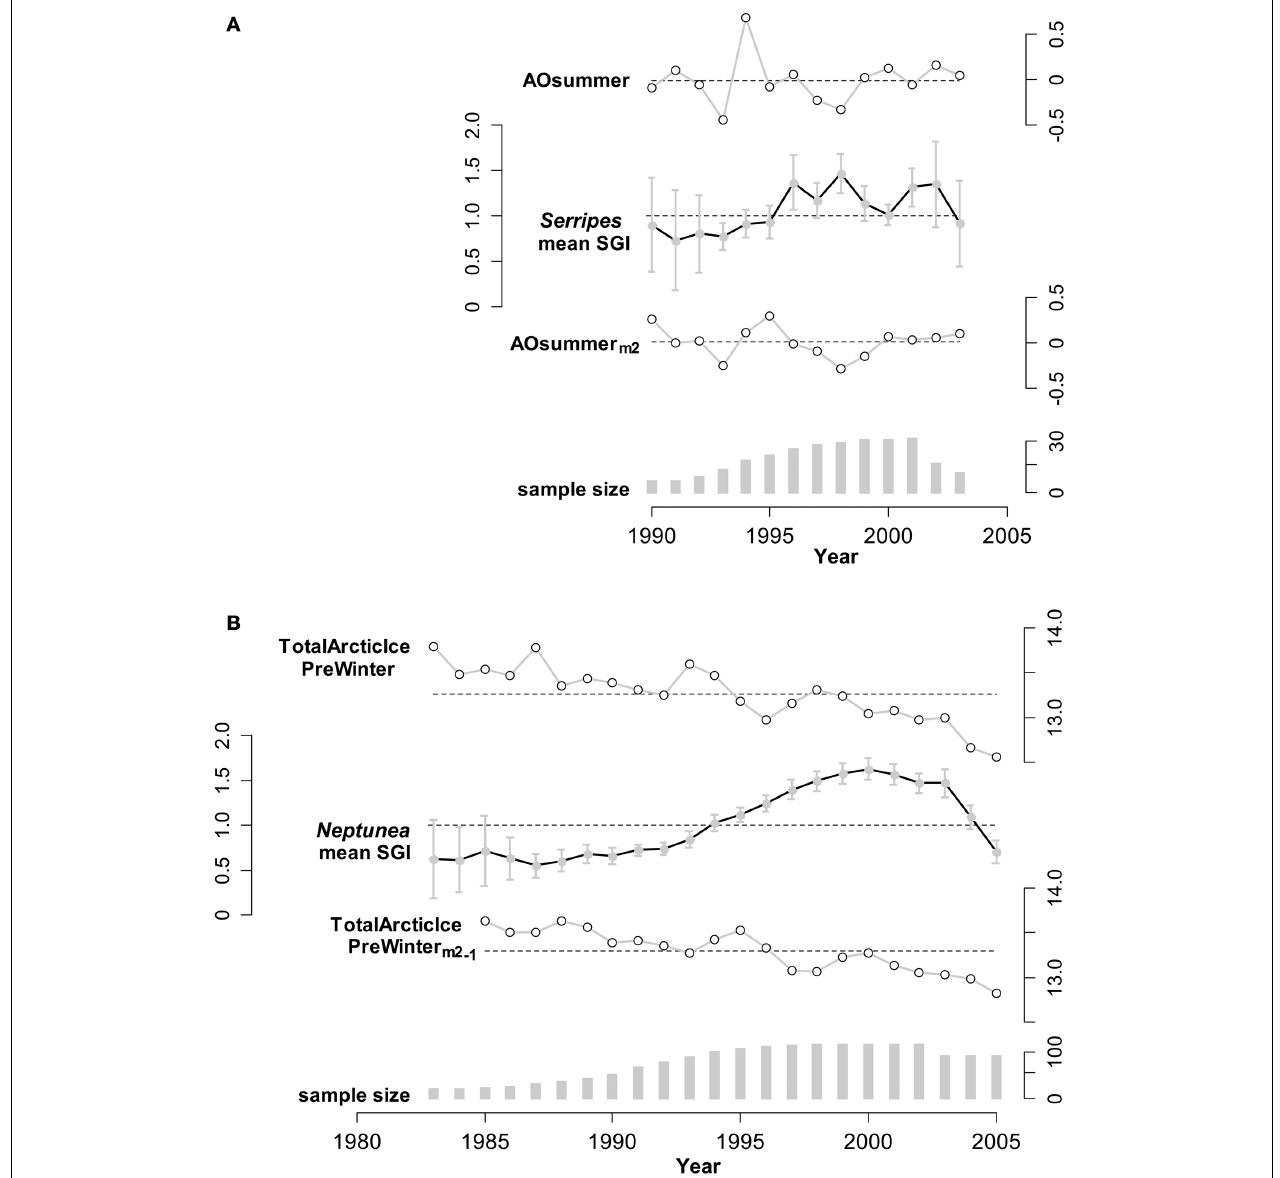
FIGURE 3 | Illustrations of annual means for an environmental predictor unmanipulated, and modified as suggested by the linear mixed modeling results (described in the text), and the SGI (Standard Growth Index; units are relative to expected growth) for: (A) Serripes , using predictor AOSummer (Arctic Oscillation; relative index), and (B) Neptunea , using predictor TotalArcticIcePreWinter (Previous Winter; units are millions of square kilometers). The scales of the variables are shown alongside the corresponding series. For each predictor, the mean across all years is shown as a dashed line; for the SGI the dashed line shows a value of 1 (expected growth = observed growth). Vertical bars are 95% confidence intervals for the SGI means, using the t -distribution